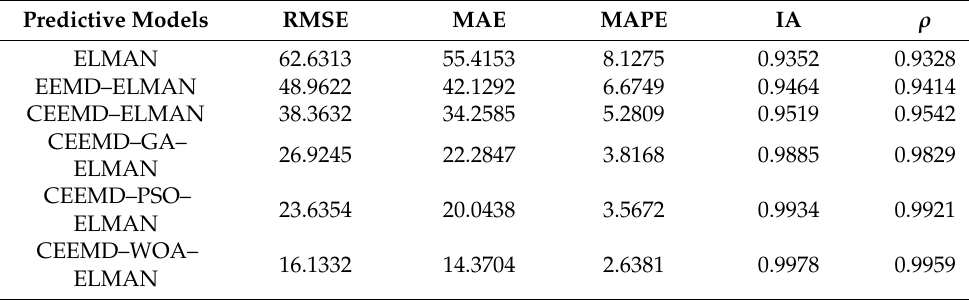
Table 2. Six model error evaluation indicators for wind turbine No. 2. Predictive Models